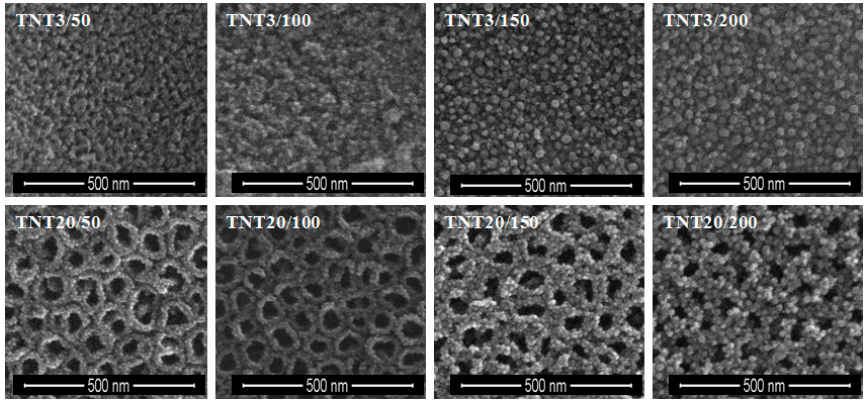
Figure 1. SEM images of TNT/Ag nanocomposite samples consisting of TNT layers prepared at 3 V and 20 V, and enriched with silver grains during 50, 100, 150, 200 ALD cycles.